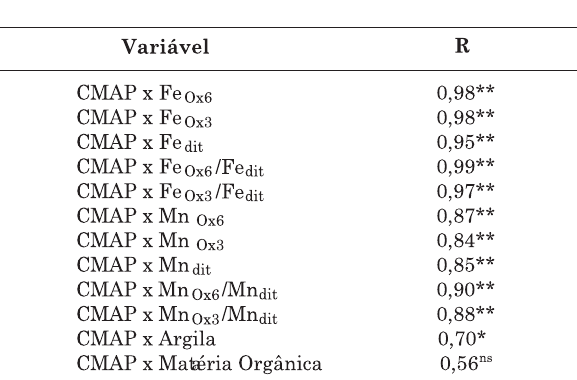
Quadro 4. Coeficientes de correlação linear simples (R) entre a CMAP e as variáveis: teores absolutos das formas de Fe e de Mn e relações entre os óxidos de baixa cristalinidade e os cristalinos nas amostras dos solos: Planossolo (SGe 3); Gleissolo, Planossolo (SGe 1); Luvissolo; Vertissolo; e